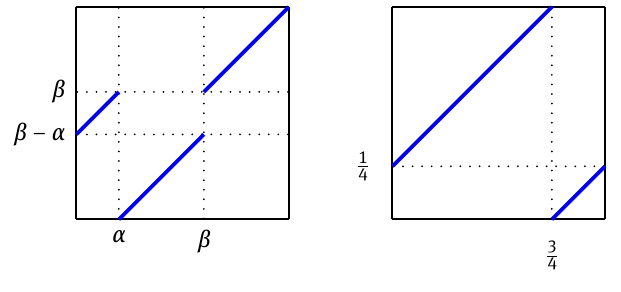
Figure 4: The supports of S α , β (left) and S 1 (cid:17) S 3